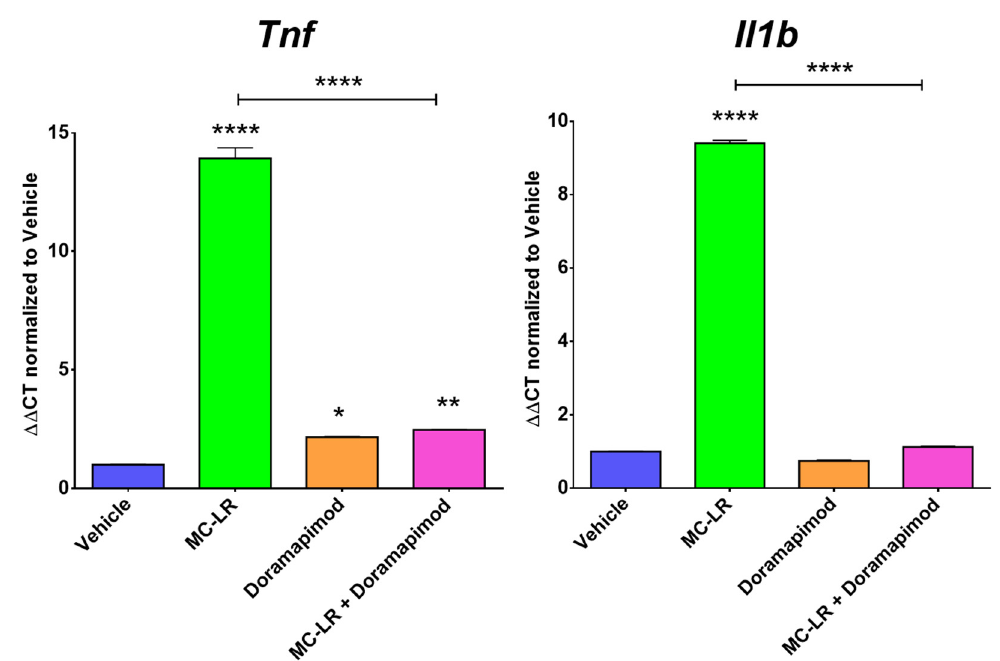
Figure 5. RT-PCR analysis for inflammatory markers Tnf and Il1b in ex vivo intraperitoneal macrophages after doramapimod pretreatment. All values are normalized to housekeeping gene 18S and presented as the mean fold change relative to vehicle control ± SEM (n = 3 samples per group). * p < 0.05, ** p < 0.01, and **** p < 0.0001 by one-way ANOVA with Tukey’s multiple comparisons.